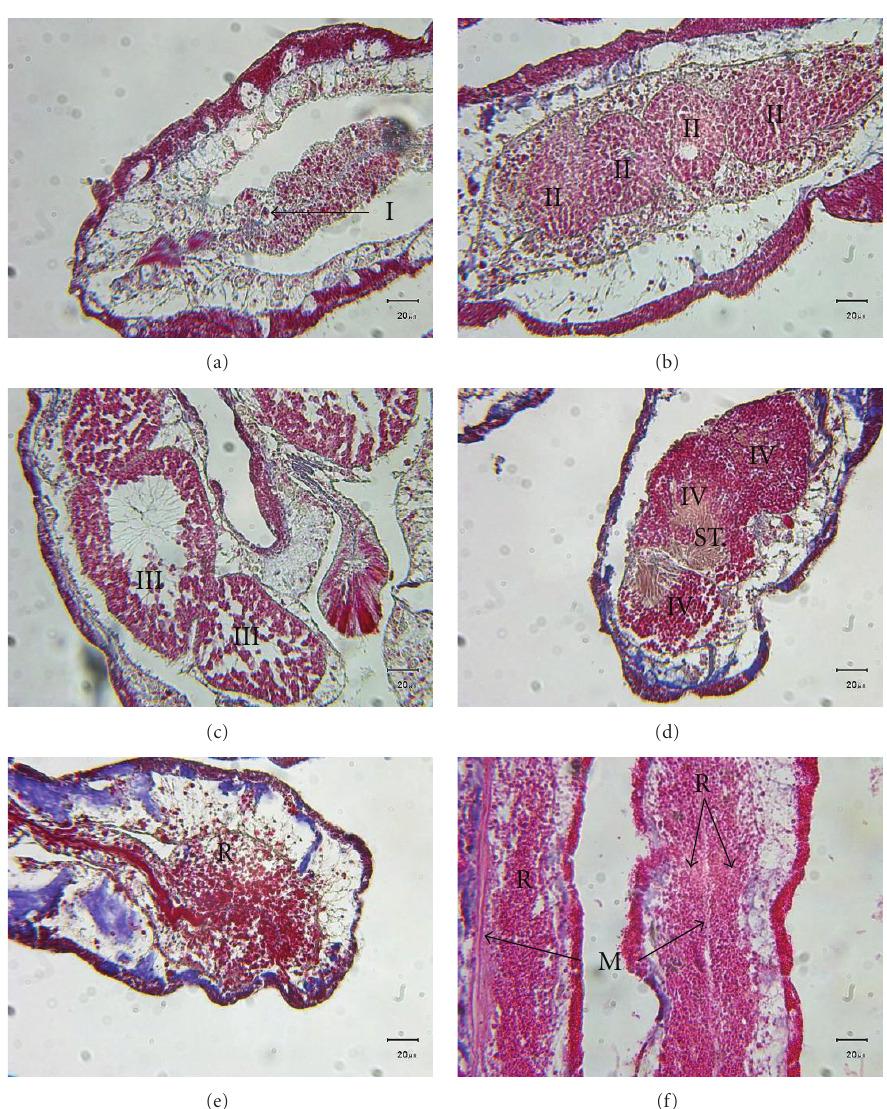
Figure 12: Photomicrographs of Stephanocoenia intersepta spermary stages I–IV (defined by Table 1). (a) Stage I spermary; (b) stage II spermaries; (c) stage III spermaries; (d) stage IV spermaries, ST = spermatozoa tails lined up; (e) released spermatozoa (R) stained with Heidenhain’s azocarmine aniline blue; (f) released spermatozoa stained with H&E, M = mesoglea. All scale bars 20 μ